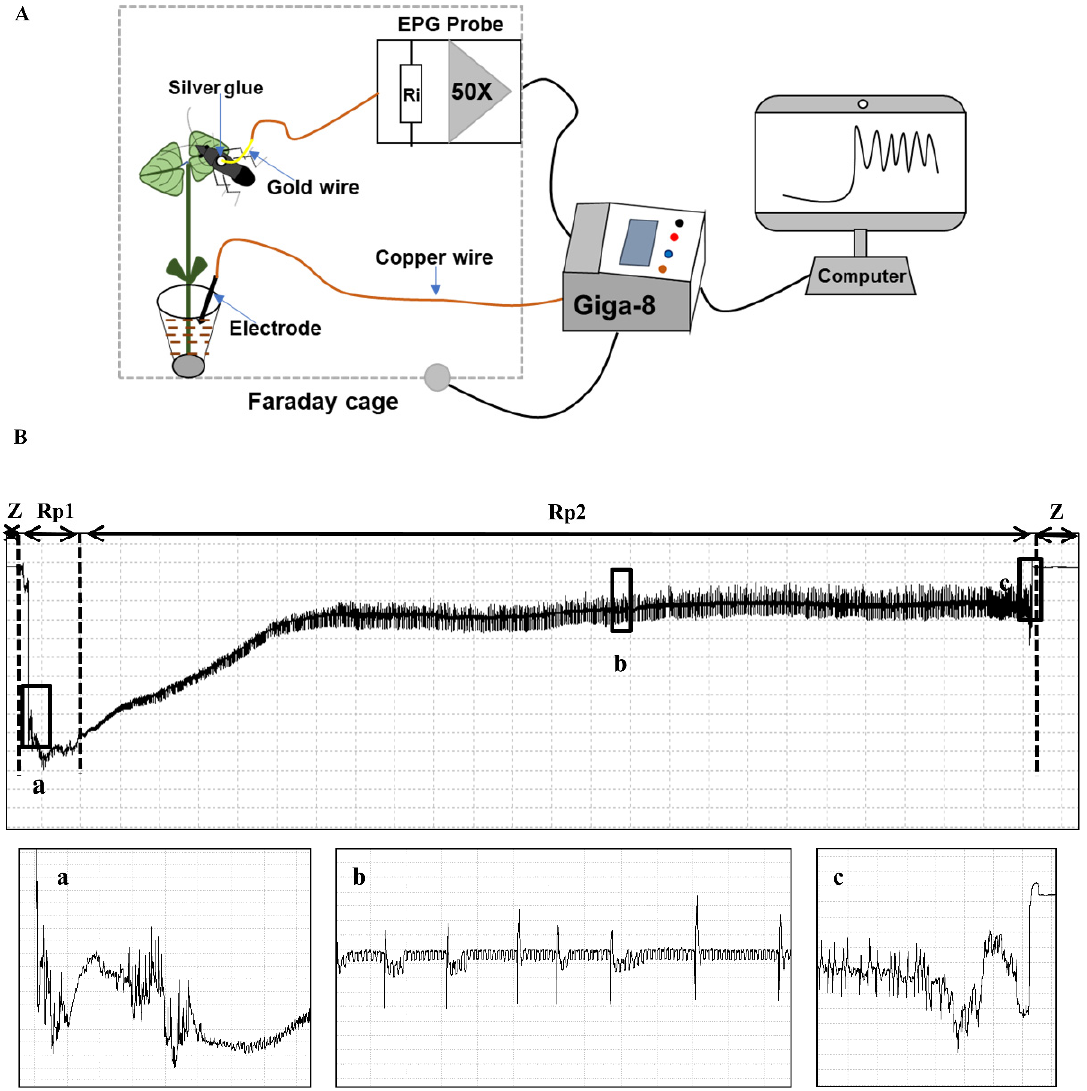
Figure 1. Demonstration of working principle of EPG ( A ), and waveforms generated using EPG for R. pedestris on leaflet, stem, and pod of soybean ( B ). Box a indicated an enlarged view of beginning of probing pathway (Rp1) from Figure 1B. Box b was an enlarged view of a part of waveform Rp2 indicated from Figure 1B. Box c showed an enlarged view of the end of Rp2 waveform when insect retracts its stylets from plant tissue on Figure